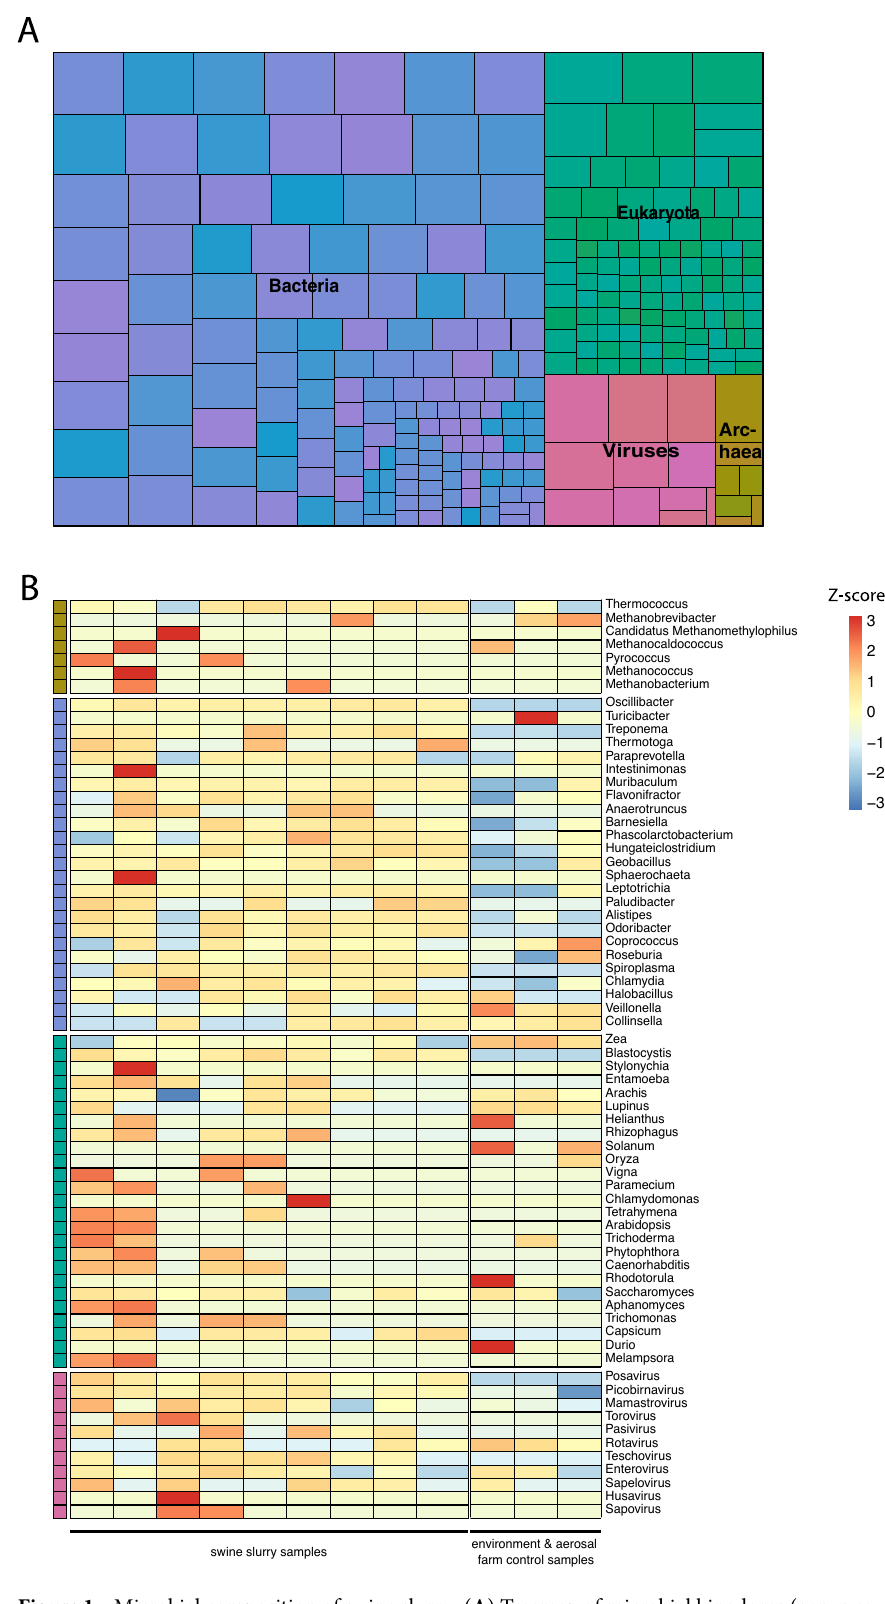
Figure 1. Microbial composition of swine slurry: ( A ) Treemap of microbial kingdoms (genus count) identified across all the nine swine slurry samples. ( B ) Top 25 most abundant genera (combined NT + NR reads per million) within each kingdom identified in the slurry